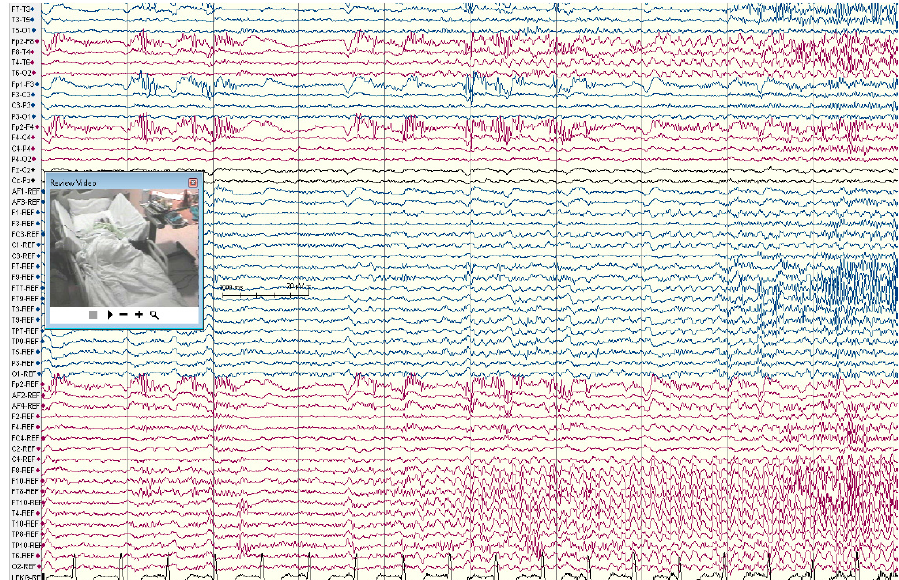
Figure 1. Right temporal lobe seizure onset in a patient with right hippocampal sclerosis and temporal lobe epilepsy (TLE). The EEG shows buildup of rhythmic repetitive sharp theta discharges arising in the right anterior-mid temporal regions. Scalp recording during long-term monitoring using extra electrodes placed according to the 10-10 electrode system for clear distinction between frontal and basal-lateral temporal head regions.